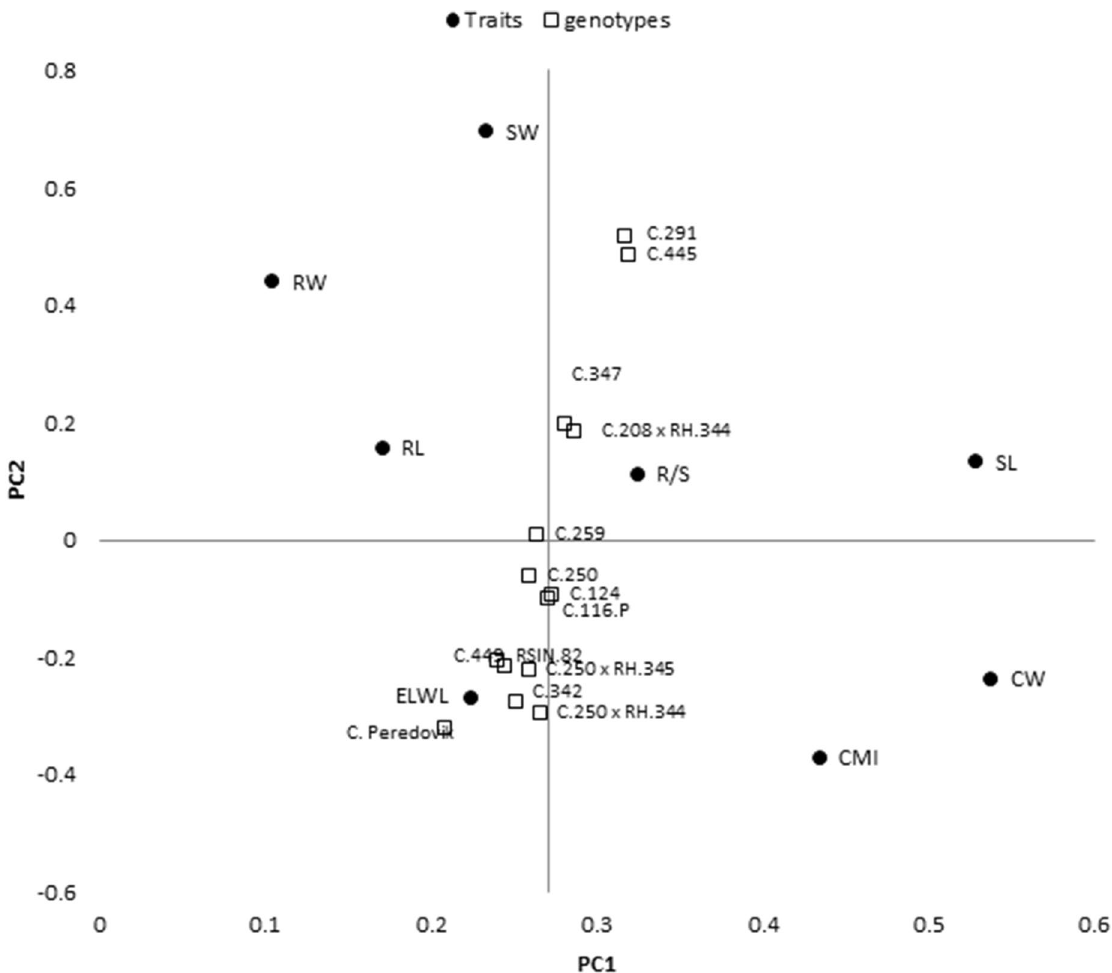
Figure 4. Genotype + Genotype × parameters, i.e. cell membrane injury (CMI), cuticular waxes (CW µg g −1